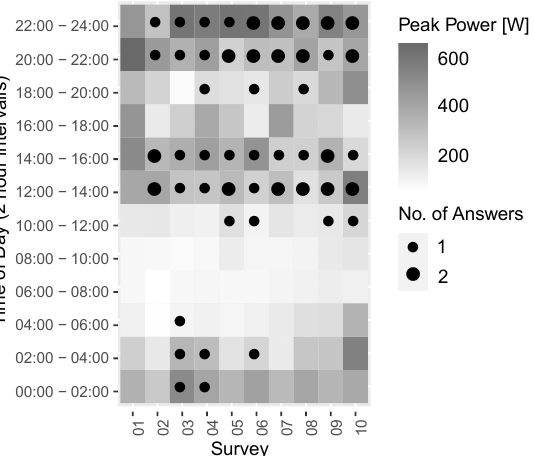
Figure 8. Self-assessment of power peaks during the day compared to the measured highest energy consumption during the residential period